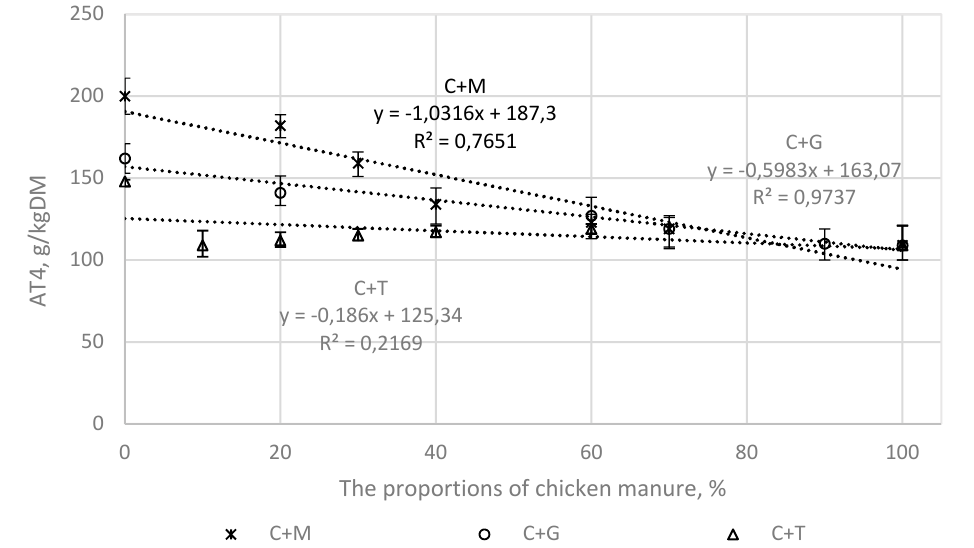
Figure 5. The correlations between COD and the proportions of chicken manure in the mixtures with co-substrates .